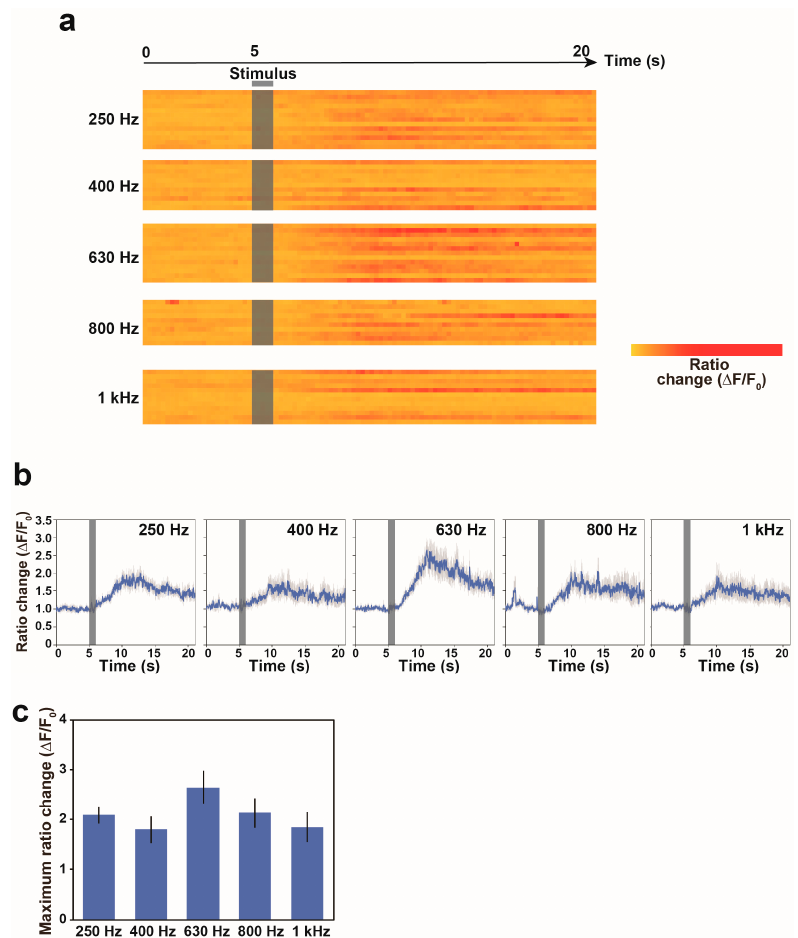
Figure 4. Calcium responses of freely behaving worms to nonlocalized vibrations with different vibration frequencies. ( a ) Heat maps showing calcium signals in the AVA neuron of freely behaving worms in response to stimulation. Each row in the heatmap shows the ratio change in a single worm. The ratio change in each bin was normalized by the maximum intensity observed in the worm responding to 630 Hz vibration. Nonlocalized vibration was evoked for 1 s and indicated as a black bar. Each line indicates a calcium response trace of the AVA neuron in one worm. ( b ) The average calcium responses of the AVA neuron in freely moving worms in response to nonlocalized vibrations. Error bars indicate standard error of the mean (s.e.m.). ( c ) The maximum calcium response of the AVA neuron in response to different nonlocalized vibrations. N = 13 worms in 250 Hz, 11 worms in 400 Hz, 13 worms in 630 Hz, 10 worms in 800 Hz and 12 worms in 1 kHz. Error bars indicate standard error of the mean (s.e.m.).